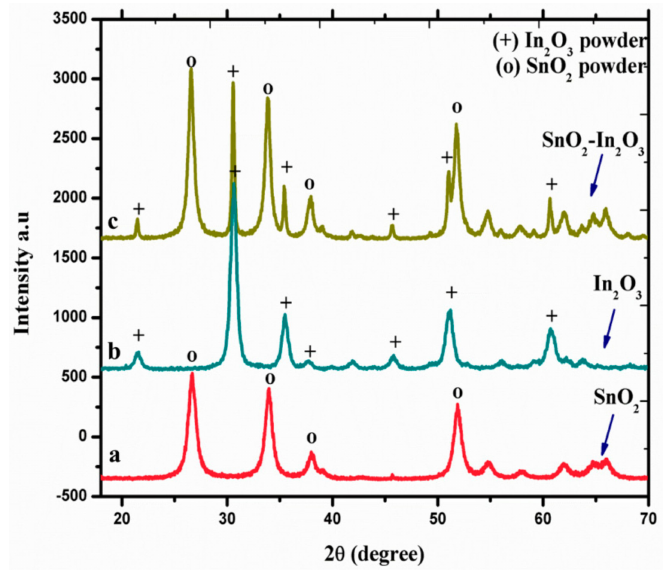
Figure 2. XRD spectra of SnO 2 , In 2 O 3 , and SnO 2 -In 2 O 3